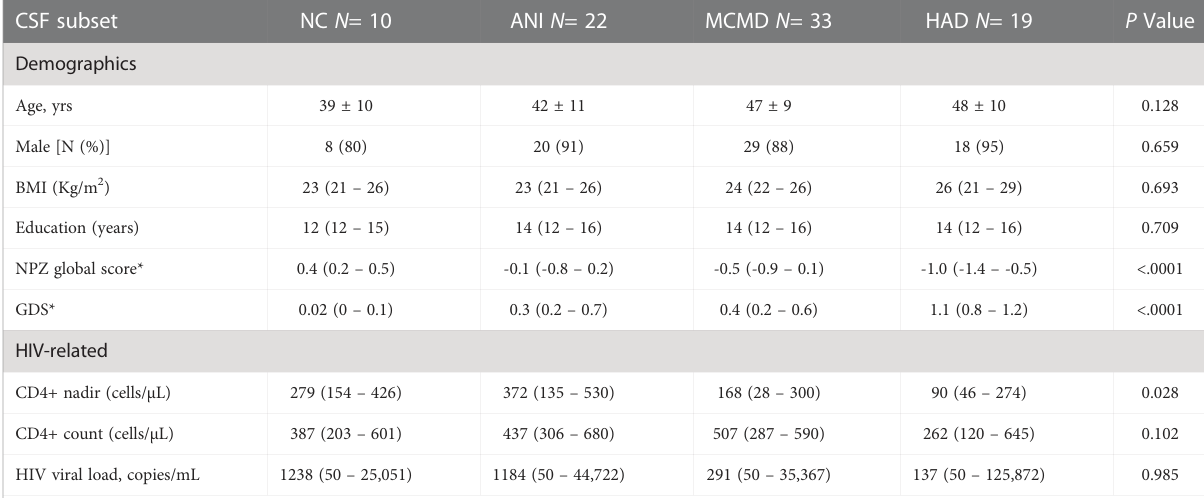
TABLE 1B Demographic and clinical characteristics of study